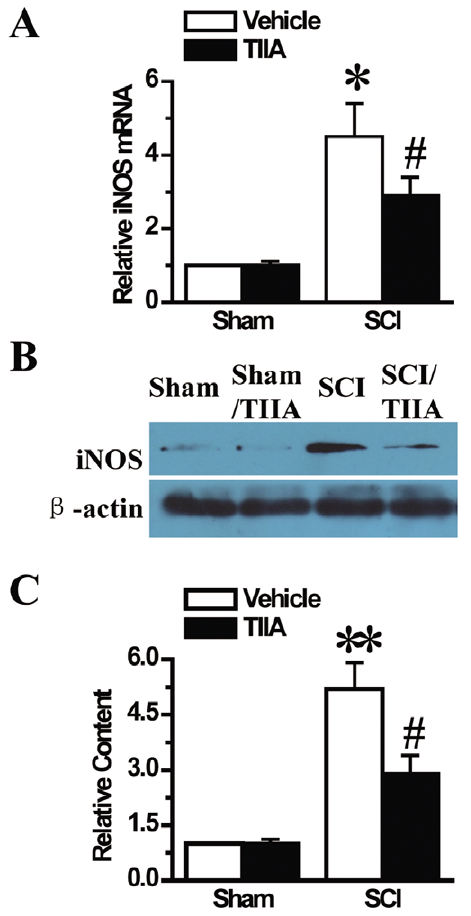
Figure 7. Effects of TIIA on the expression of iNOS at 24 h after SCI. RT-PCR results demonstrated that the expression of iNOS was increased after SCI. Treatment of TIIA decreased the mRNA level of iNOS compared to the SCI group (A). Western blot analysis demonstrated that the protein expression of iNOS was increased in the tissues from the SCI group, but the treatment of TIIA significantly reduced the level of iNOS (B). The analyzed data for relative iNOS protein content are shown (C). Bars represent means 6 SEM. * p , 0.05, ** p , 0.001 vs. sham group; # p , 0.05 vs. SCI group.